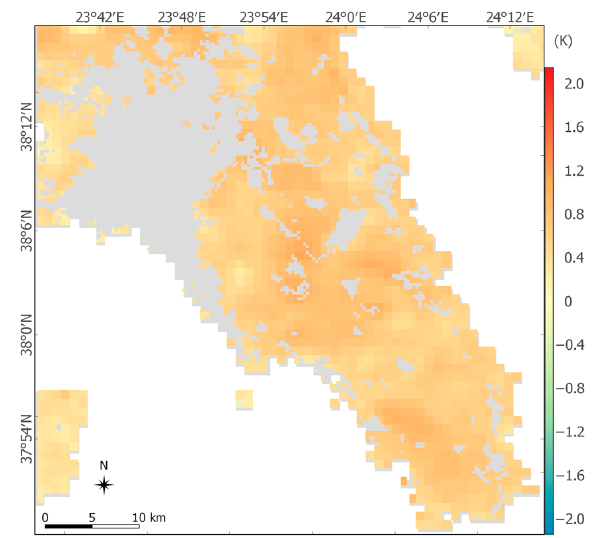
Figure 10. LST trend values (in °K) of the urban pixels of Athens (Nighttime).